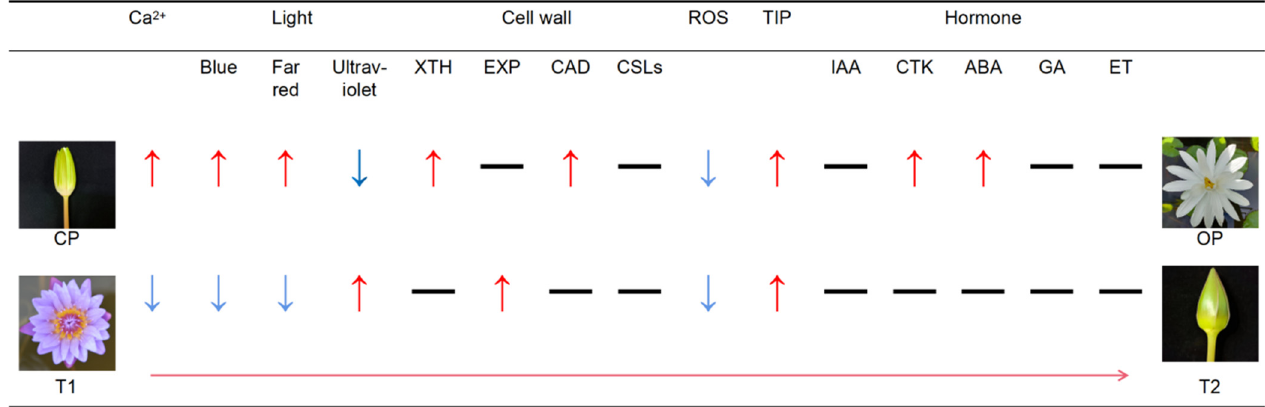
Figure 7. Schematic model of the molecular mechanism differences in petal opening and closing between two waterlily species. ↑ indicates upregulated gene expression, ↓ downregulated gene expression, — indicates that these genes jointly regulate the opening and closing of petals, → indicates the process from CP to OP and the process from T1 to T2.